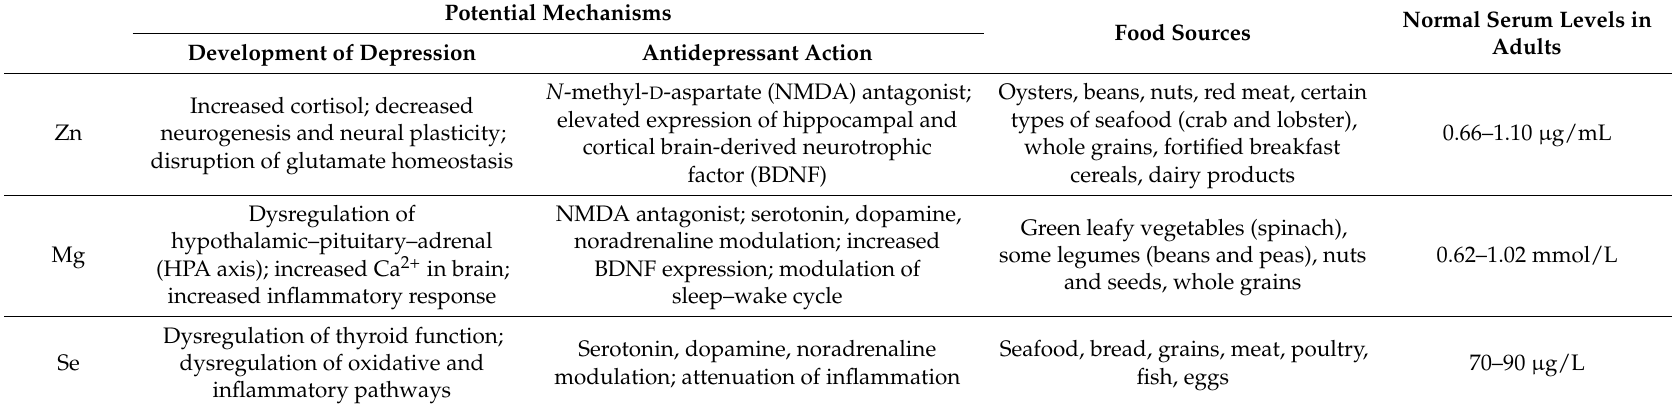
Table 1. Potential Mechanisms, Food Sources, and Normal Serum Levels of Zinc (Zn), Magnesium (Mg), and Selenium